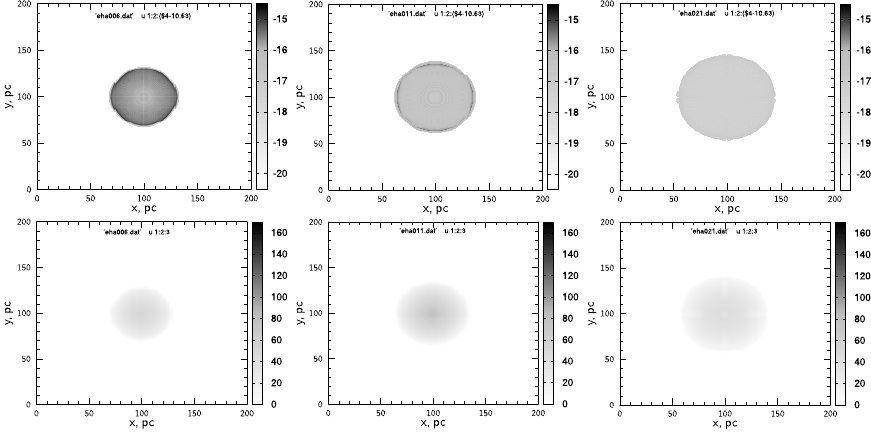
Fig. 2. H (cid:11) intensity I H (cid:11) (in erg cm (cid:0) 2 s (cid:0) 1 arcsec (cid:0) 2 ) (the top row) and velocity dis- persion (in km s (cid:0) 1 ) (the bottom row) maps for a single SN explosion at t = 0 : 1, 0.2 and 0.4 Myr (from left to right). is very close to that of gas cooled from very high temperature, T = 10 8 K